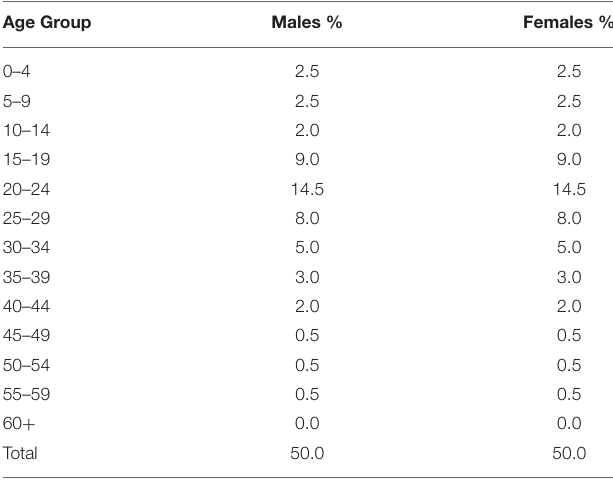
TABLE 1 | Standard percentage age and sex distribution of net international